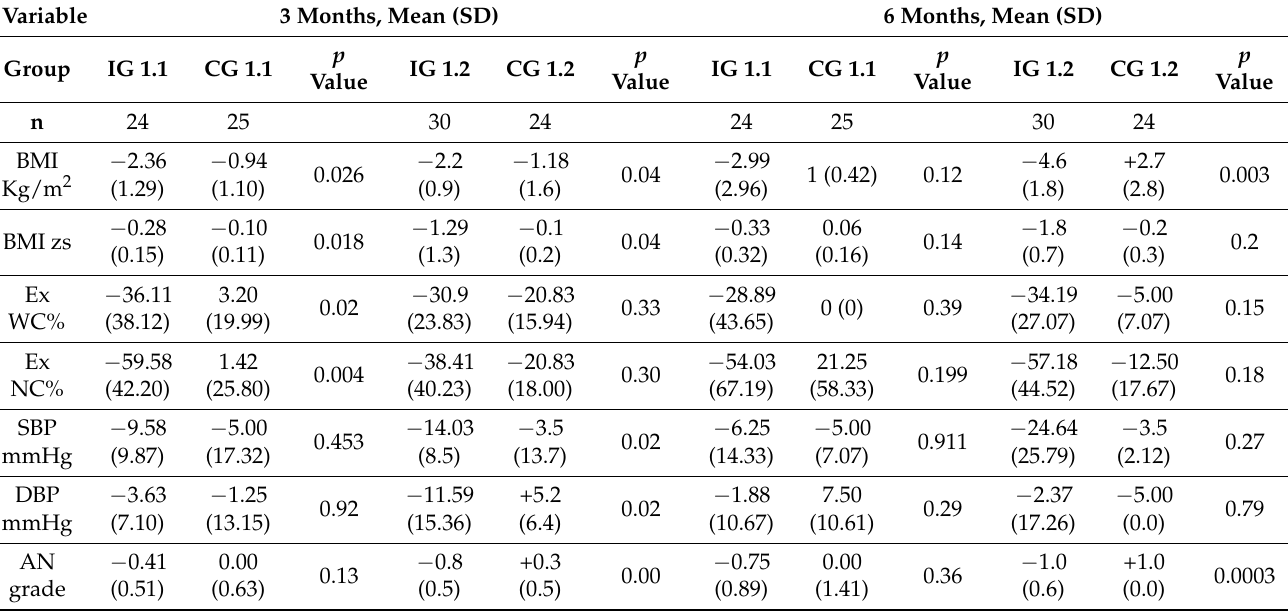
Table 3. Changes in anthropometric